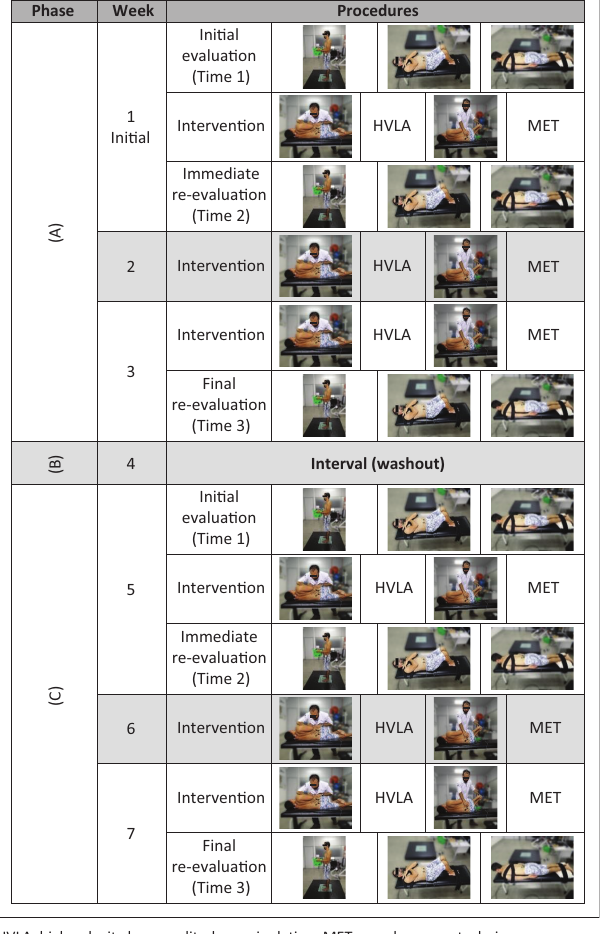
FIGURE 3: Crossover study interventional model description.